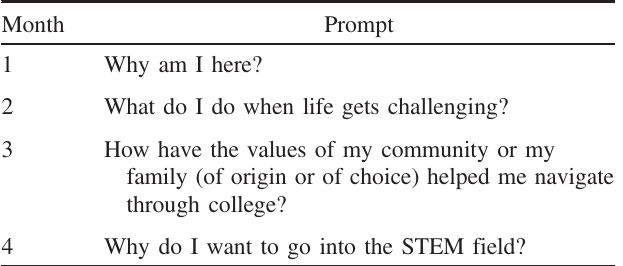
TABLE III. Final Alma Project reflective journaling prompts used in General Physics I Lab and SI